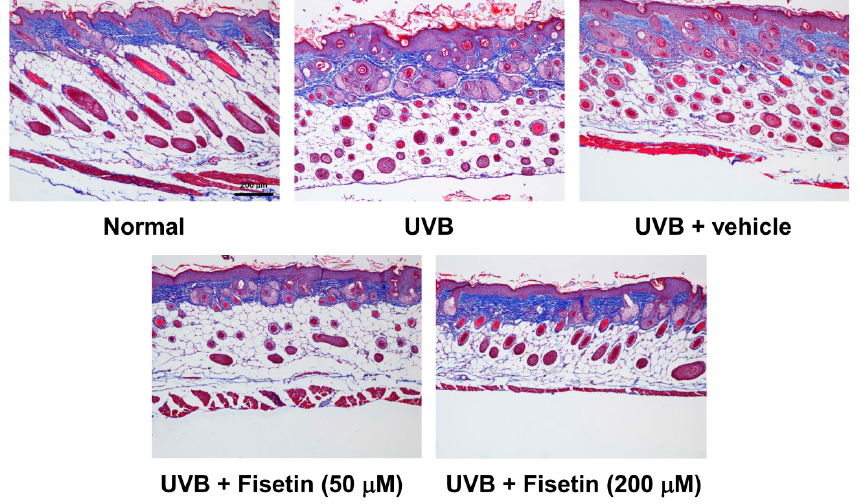
Figure 6. Light micrographs of the histological sections of the hairless mice stained with Masson trichrome. Collagen fibers are stained in blue in the dermis.